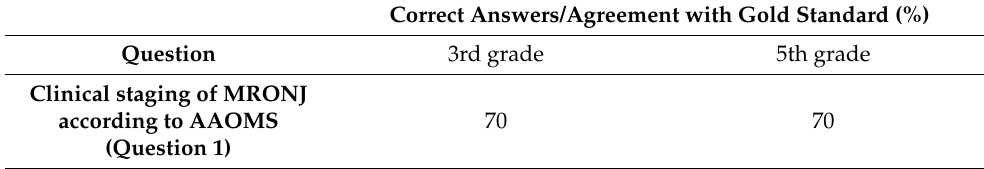
Table 2. Proportion of correct answers and agreement with the gold